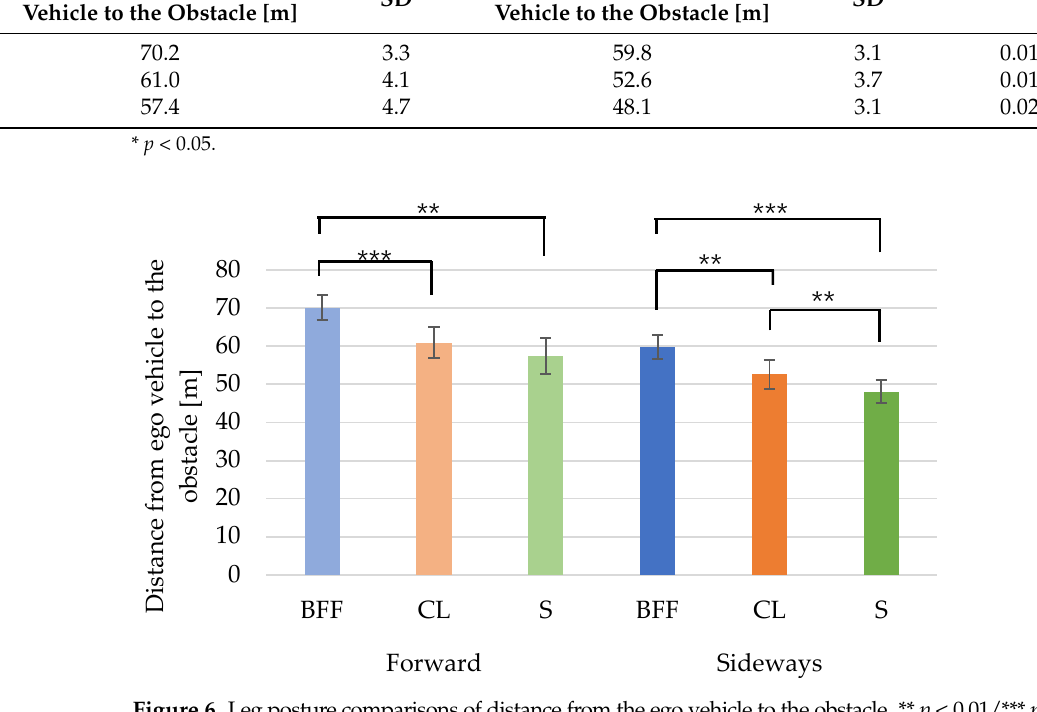
p -ValueDistance from the Ego